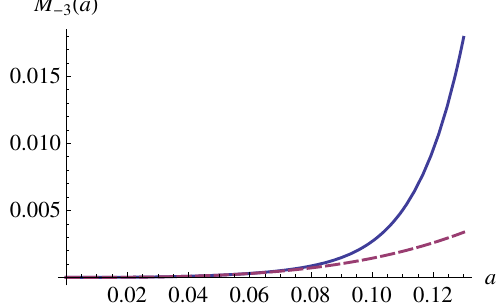
Figure 17. Mass–radius relationship (in 10 − 3 M (cid:12) units for mass and 10 − 6 R (cid:12) for radius a ) for a stellar fragment (with temperature θ = 0.824). Dashed line plots the relationship in the newtonian approximation.